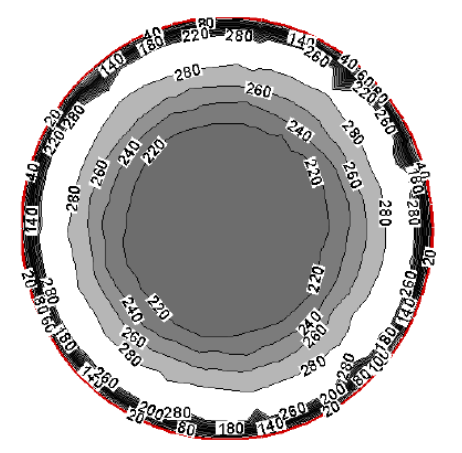
Figure 14. Contours of velocity distribution (m/s) at 1.5 cm along axial direction from the inlet nozzle in hot end at 5 bar inlet